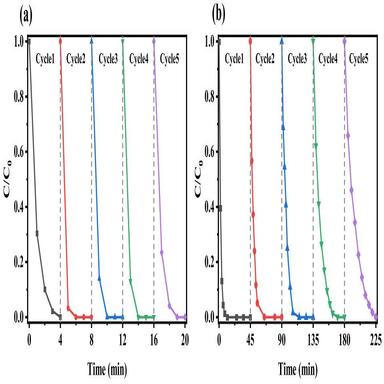
Reusability comparison of (a) CuO-NiO/NC-600 and (b) Cu3Ni/NC-550-one year catalysts in successive five runs. Experimental conditions: = 0.72 g/L, = 0.72 g/L, = 1.3 mM, = 12.5 mg/L, initial pH = 9, temperature = 25 ℃.